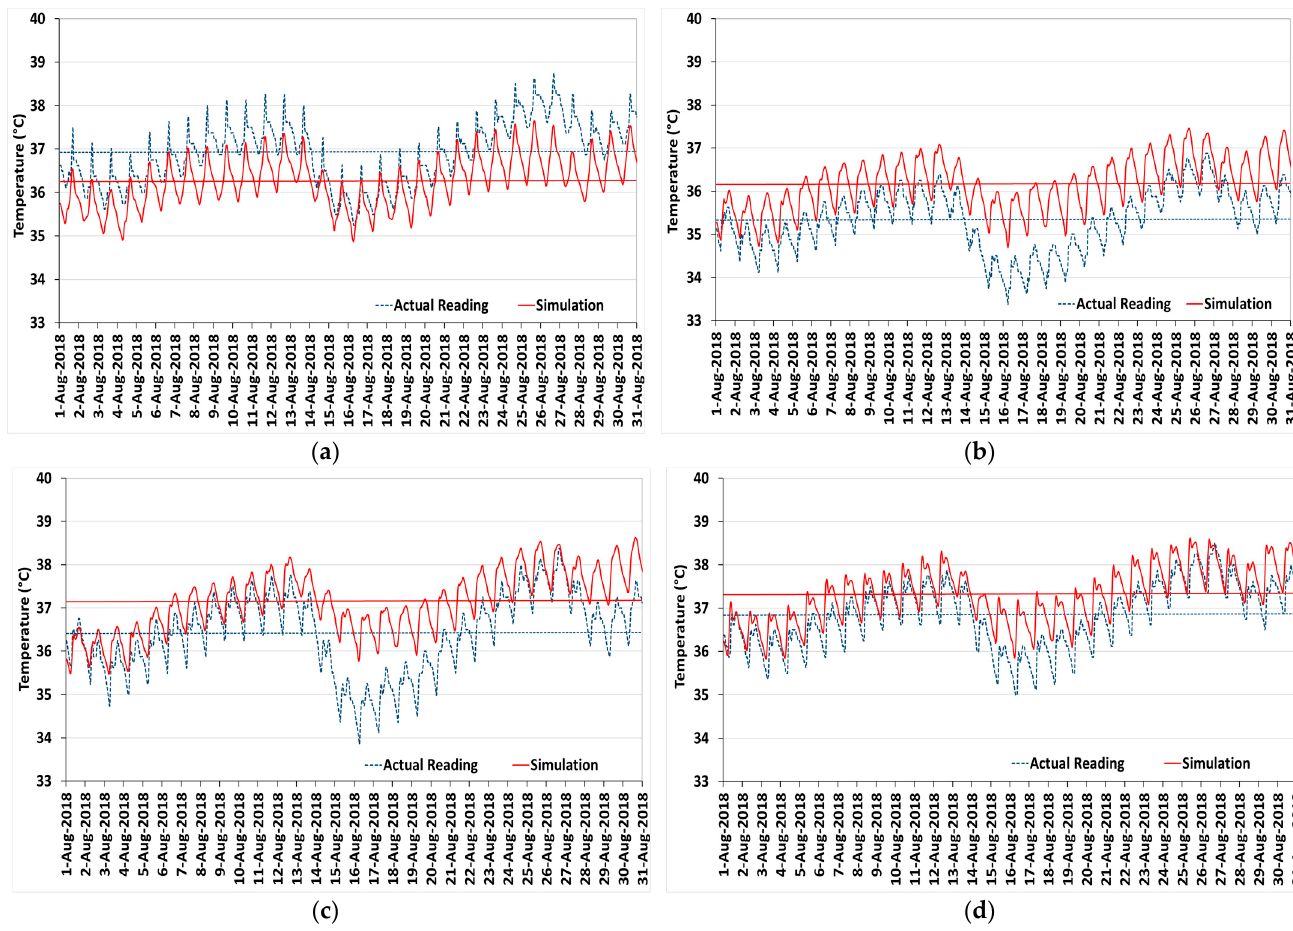
Figure 3. The comparison between the simulated and actual indoor temperatures for different